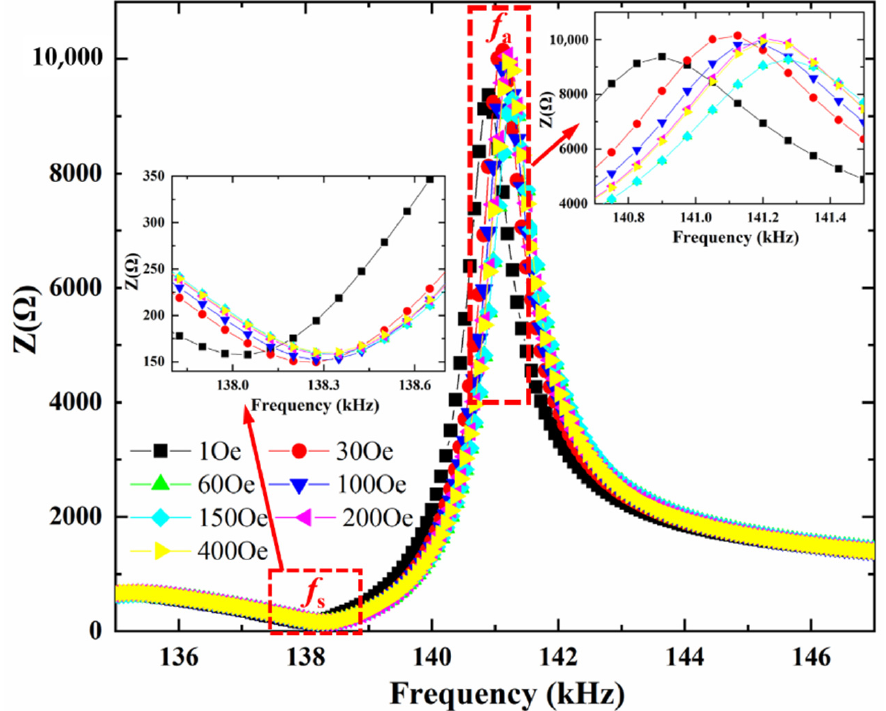
Figure 1. Impedance curve of the ME sensor at various bias DC magnetic fields, and the insets show enlarged details around the maximum and minimum impedances. The maximum relative standard deviations (RSD, i.e., standard deviation/mean × 100%) of impedance with multiple measurements is 0.27%.